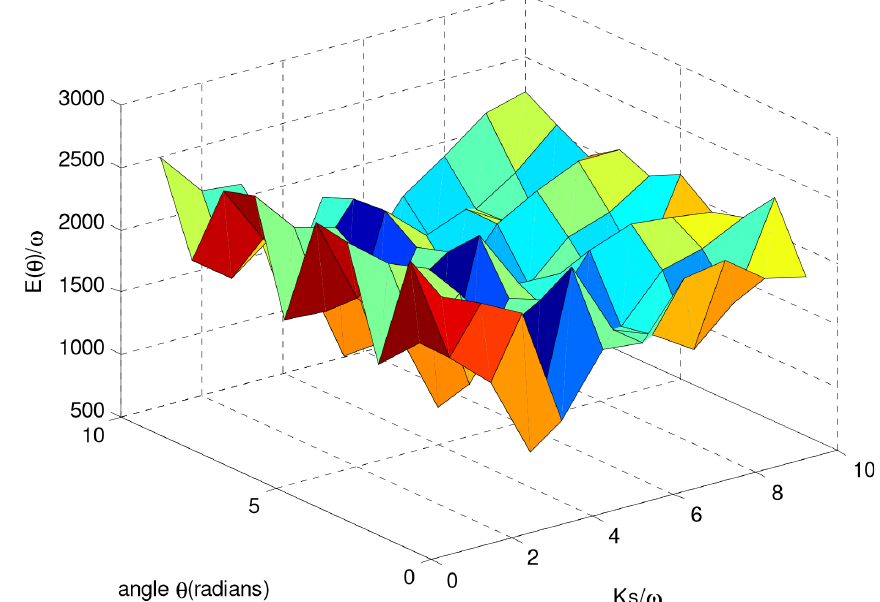
Figure 3: 3-D plot of energy versus angle and stress induced anisotropy for N = 3.